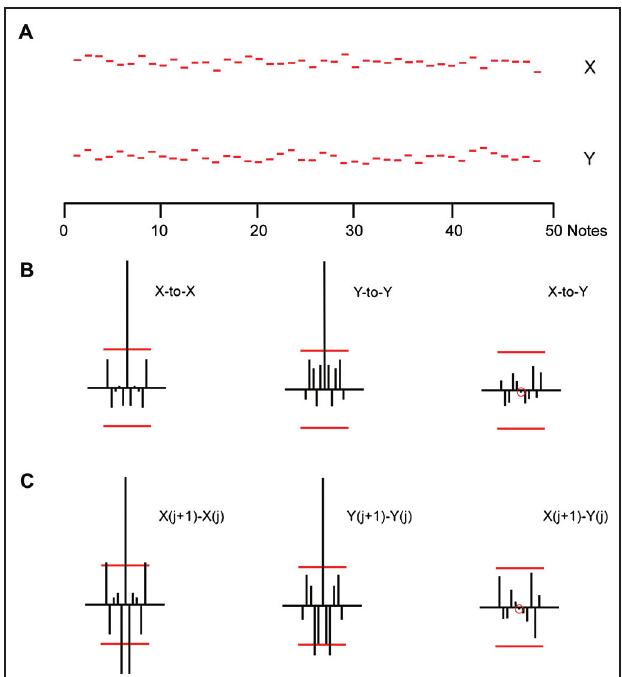
FIGURE 4 | (A) Alternating positions of X and Y simulated using a dual Wiener process (martingale) model. (B) Serial correlation coefficients for the simulated sequences. Left: serial auto-correlation coefficients for X. Middle: same for Y. Right: cross-serial coefficients with X the reference. (C) Serial correlation coefficients for the sequential differences between simulated sequences. Left: Serial auto-correlation coefficients for the sequential differences within sequence X. Middle: same for Y. Right: cross-serial correlations between sequential X and Y differences. Note X is the